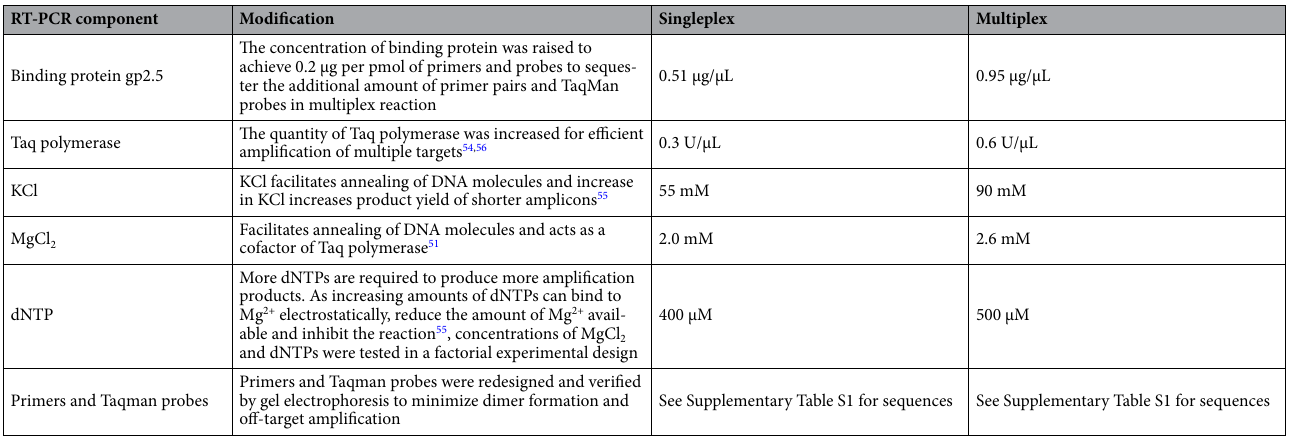
Table 1. Summary of modifications to RT-qPCR components for efficient multiplex